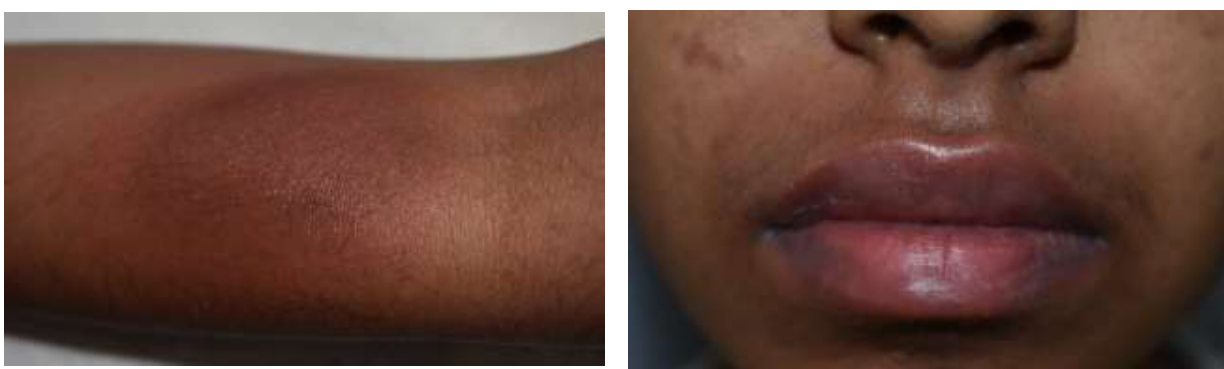
Figure 1: Skin lesions following ingestion of cetirizine Figure 2: Mucosal lesions following ingestion of